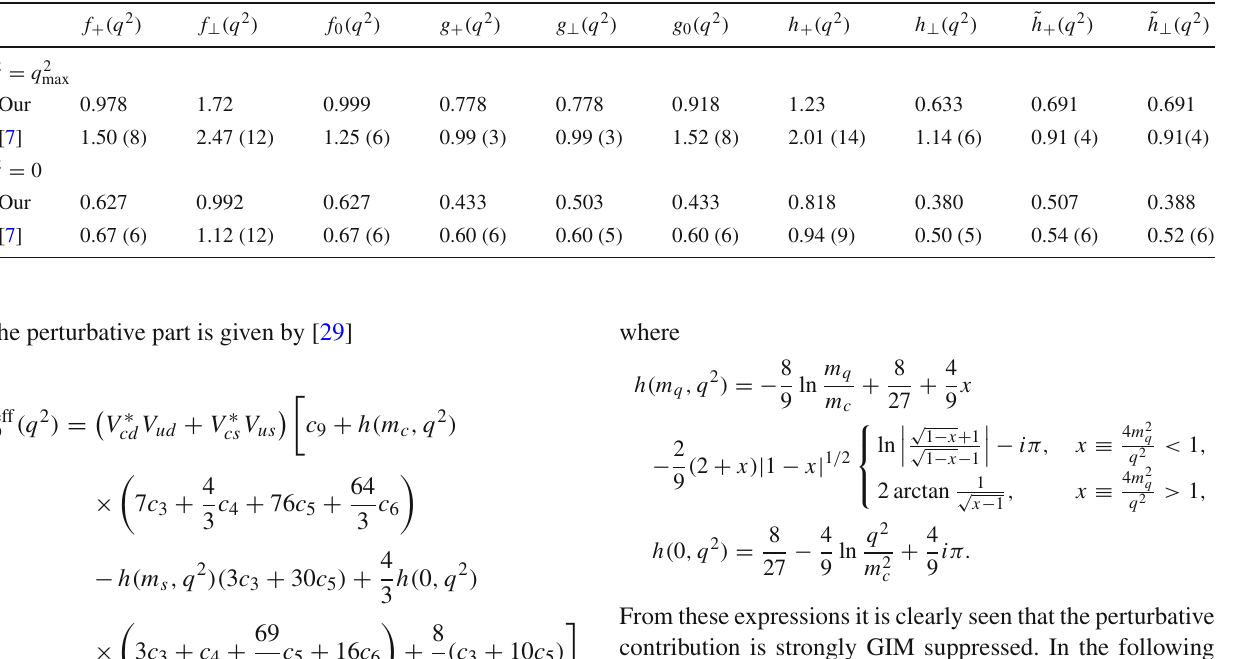
Fig. 2 Helicity form factors of the rare (cid:2) c → p transition Table 3 Comparison of our predictions with lattice data for the helicity form factors of weak baryon (cid:2) c → p decays at minimum q 2 = q 2 max and maximum q 2 = 0